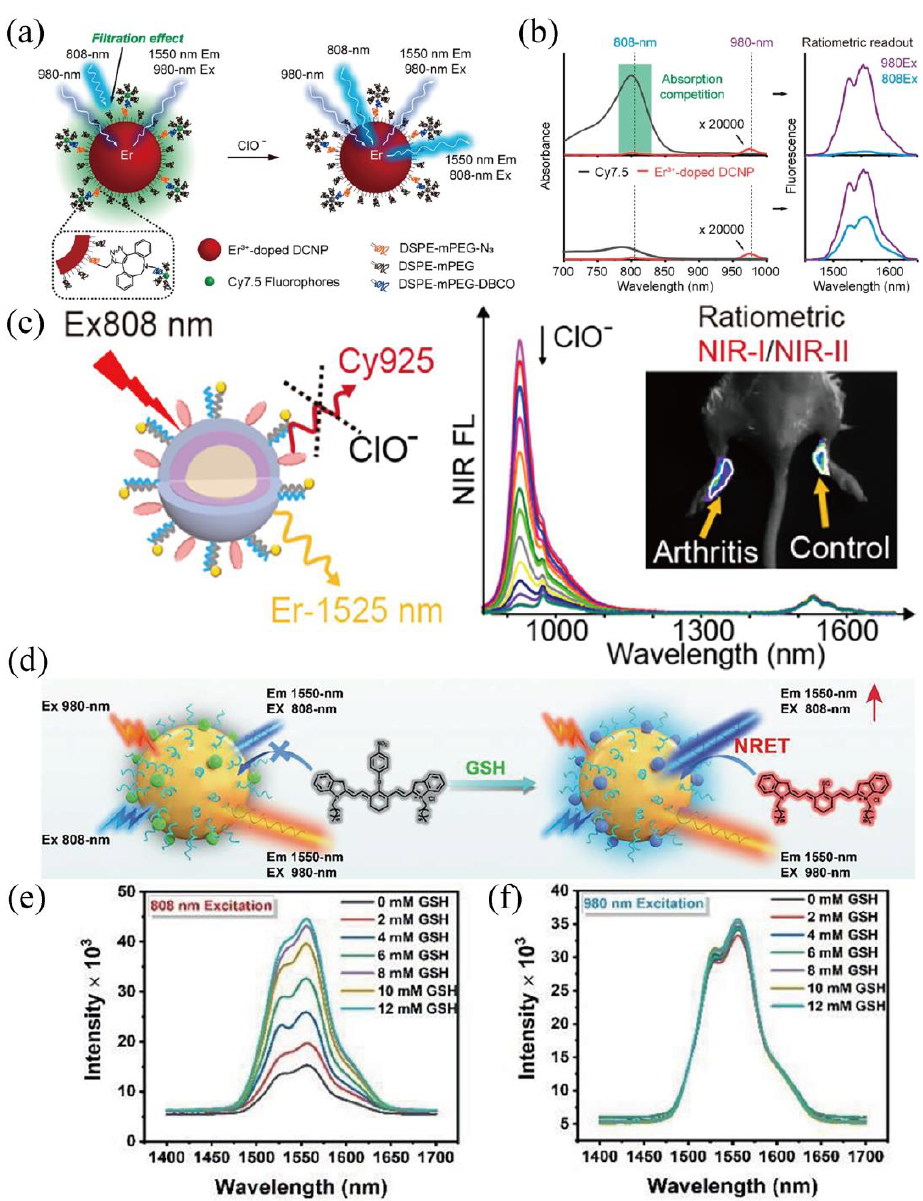
Figure 8. ( a , b ) Schematic design of the LnNCs@Cy7.5 for ClO − detection. Adapted, with permission, from Ref. [91]. Copyright 2019, American Chemical Society. ( c ) Schematic illustration of the LnNCs@Cy925 for ClO − detection. Adapted, with permission, from Ref. [93]. Copyright 2019, Amer- ican Chemical Society. ( d ) Schematic illustration of the LnNCs@NPh for GSH detection. ( e , f ) NIR−II spectra of the LnNCs@NPh under 808 nm and 980 nm, respectively. Adapted, with permission, from Ref. [96]. Copyright 2021, Wiley−VCH.